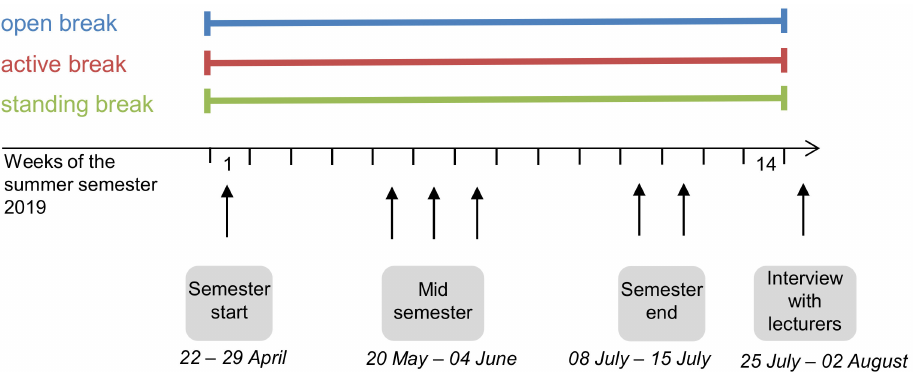
Figure 2. Study design with all study groups and the survey time